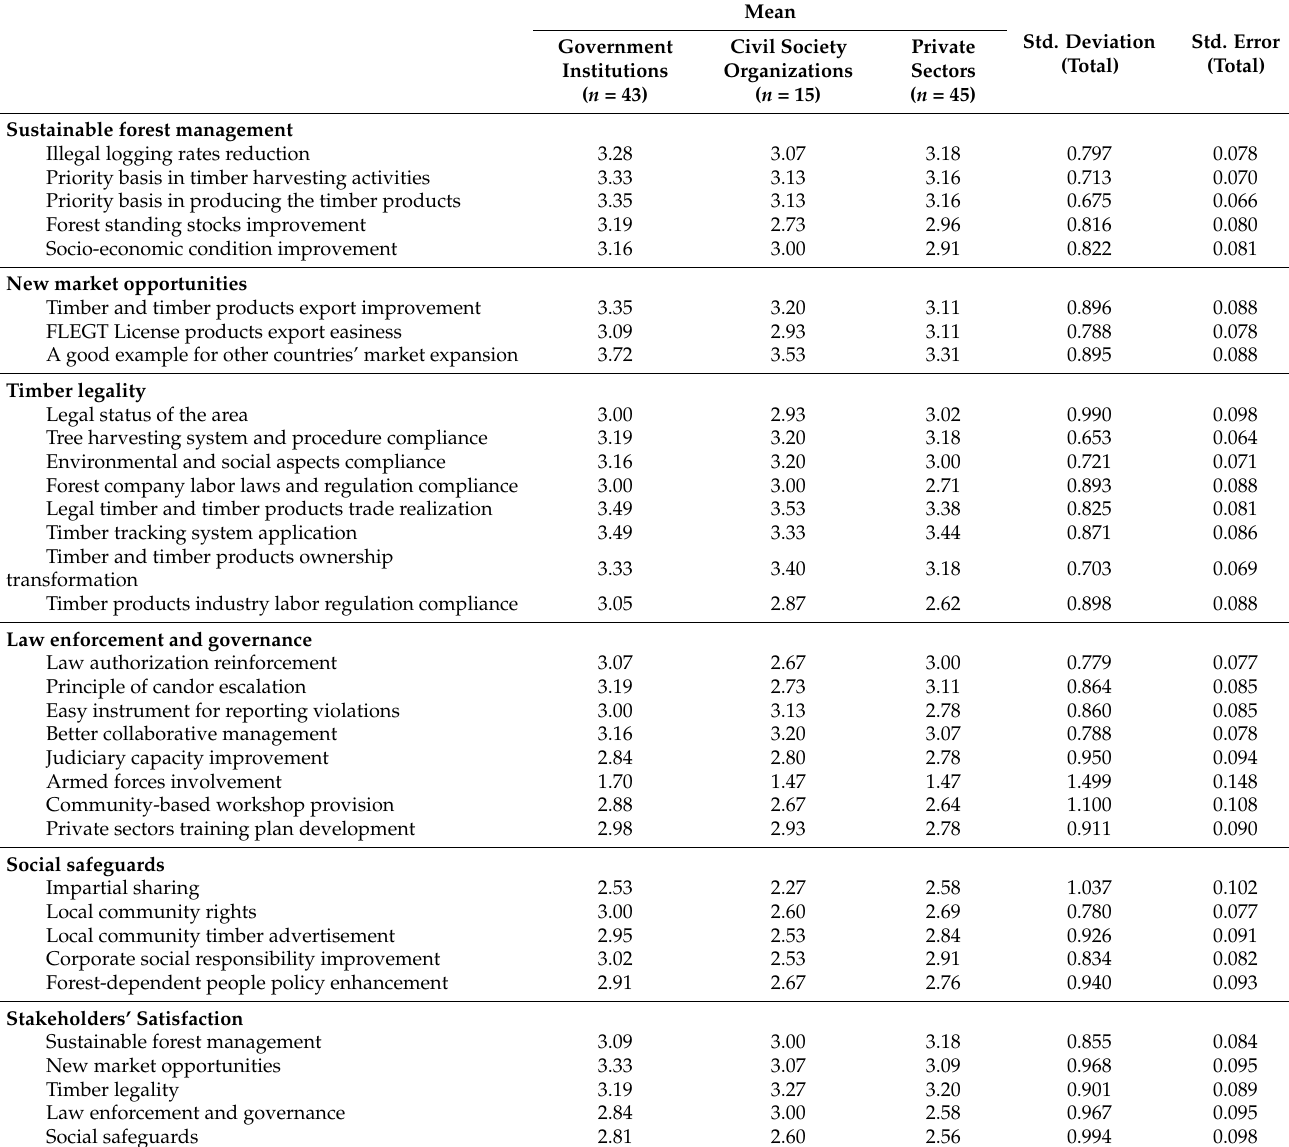
Table 2. Stakeholders’ satisfaction ( n = 103) on the Indonesia–EU FLEGT-VPA scheme implementation.